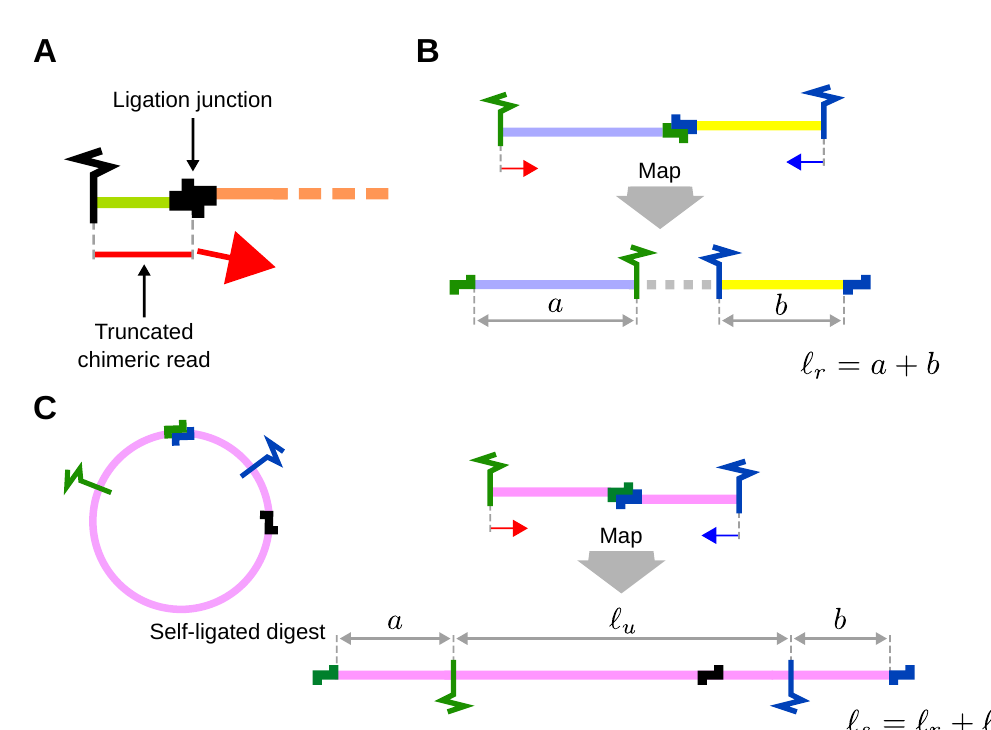
Figure 5. Truncation of reads and calculation of fragment and digest sizes. Ligation junctions are sought in 5’-3’ direction; reads are 3’-truncated after any idenfitifed ligation junction. ( A ). Read pairs correspond to the outermost ends of fragments. The size of ligation fragments ( l r ) is calculated by summing up the sizes of the two segments that form the fragments ( B ). The size of self-ligating digests is calculated by adding the size of the un-ligated part ( l u ) of the digest to the calculated fragment size ( C